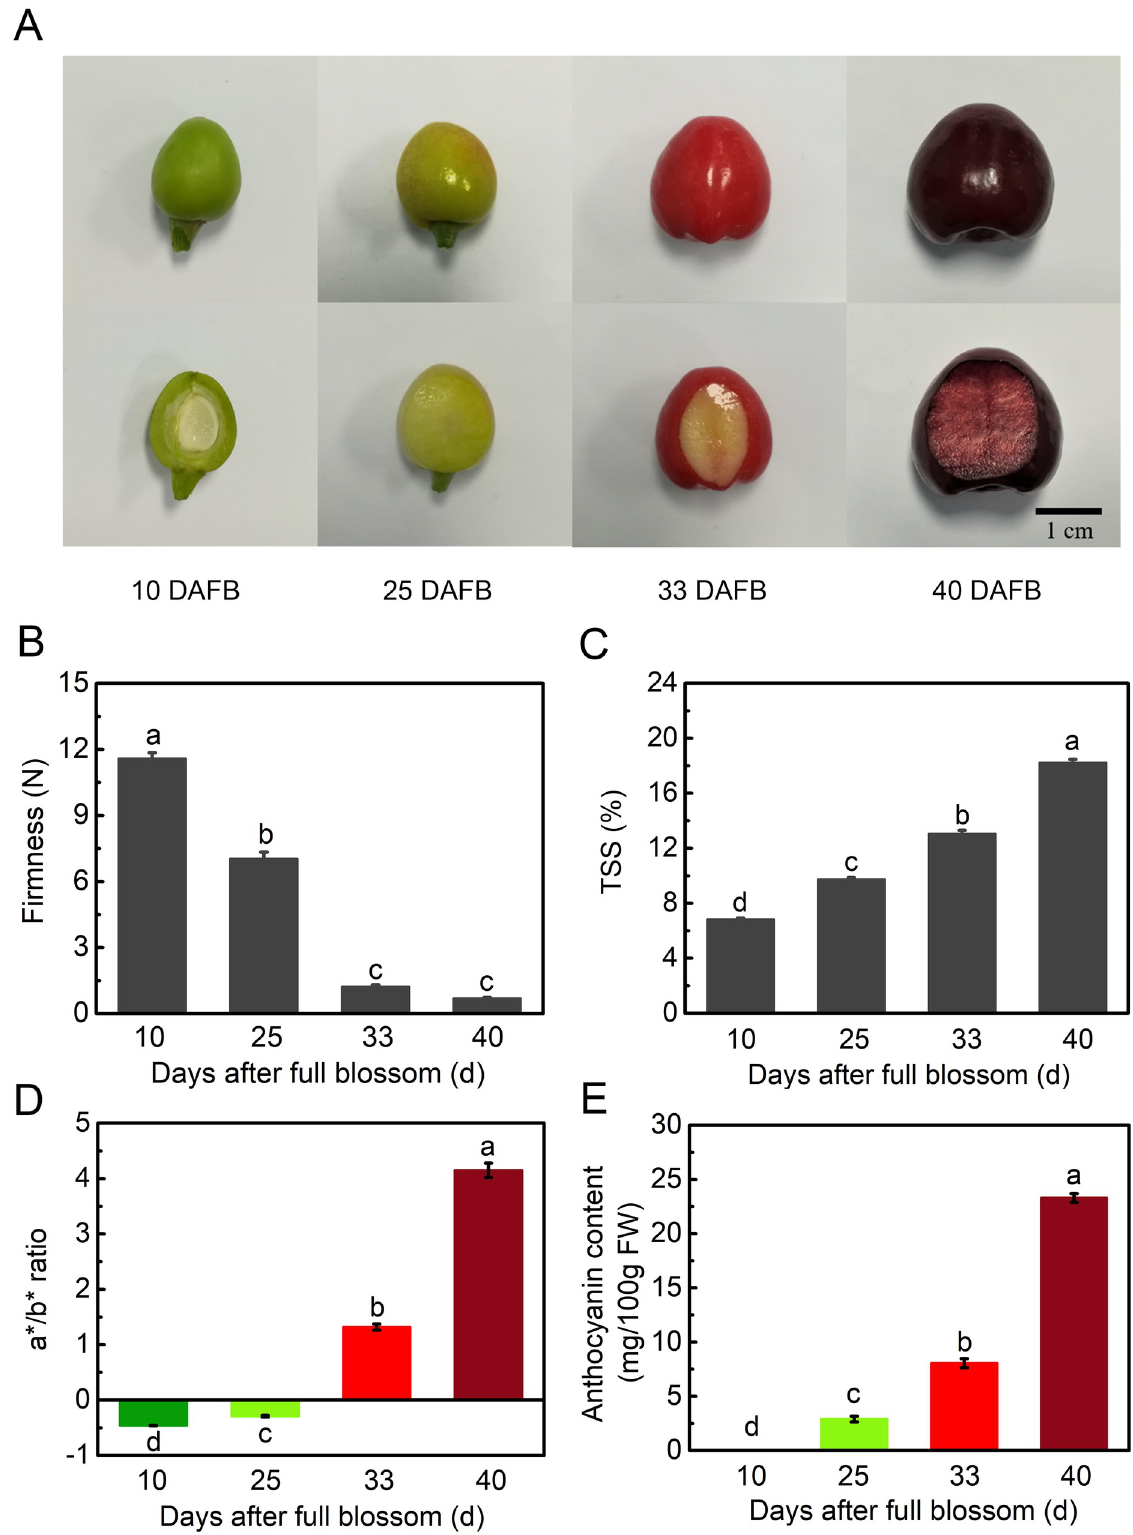
Fig 1. Physiological and morphological changes during sweet cherry ( Prunus avium L. cv. ‘Black Pearl’) fruit development. (A) Photos of developmental stages. (B) Fruit firmness (N). (C) Changes in total soluble solids (TSS). (D) Changes in a � /b � ratio. Error bars in (B), (C),